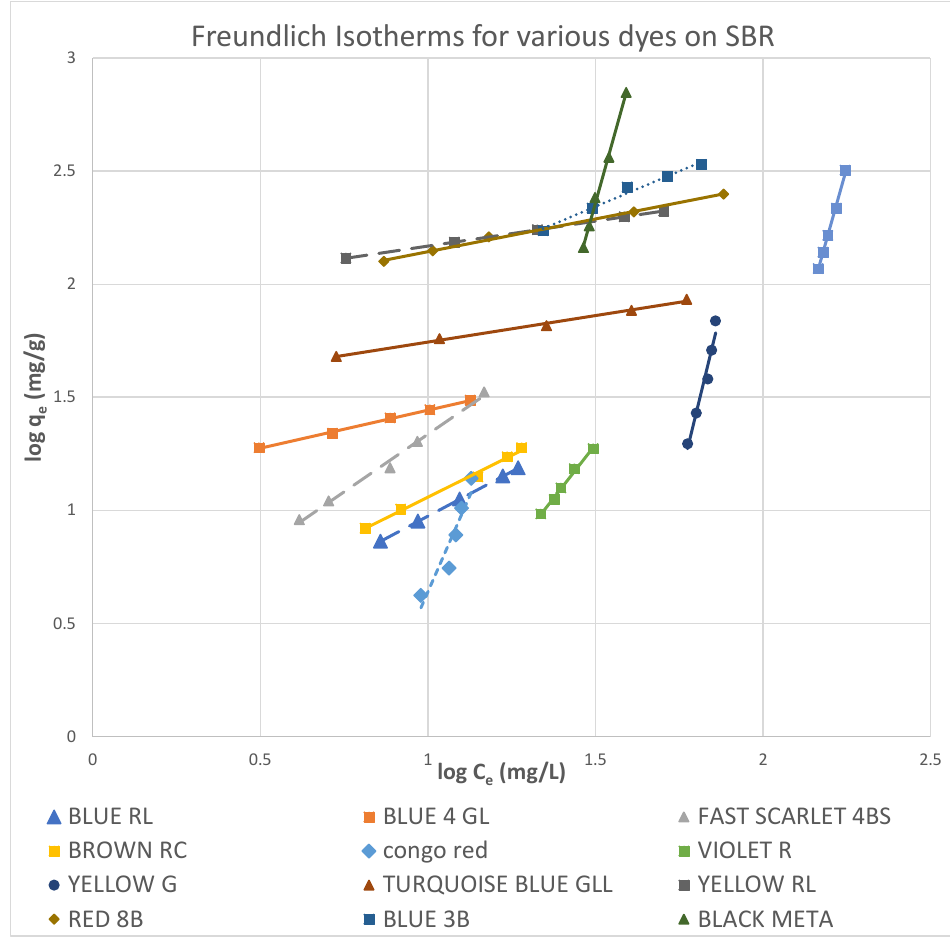
Figure 10. Freundlich isotherms for various dyes on SBR.